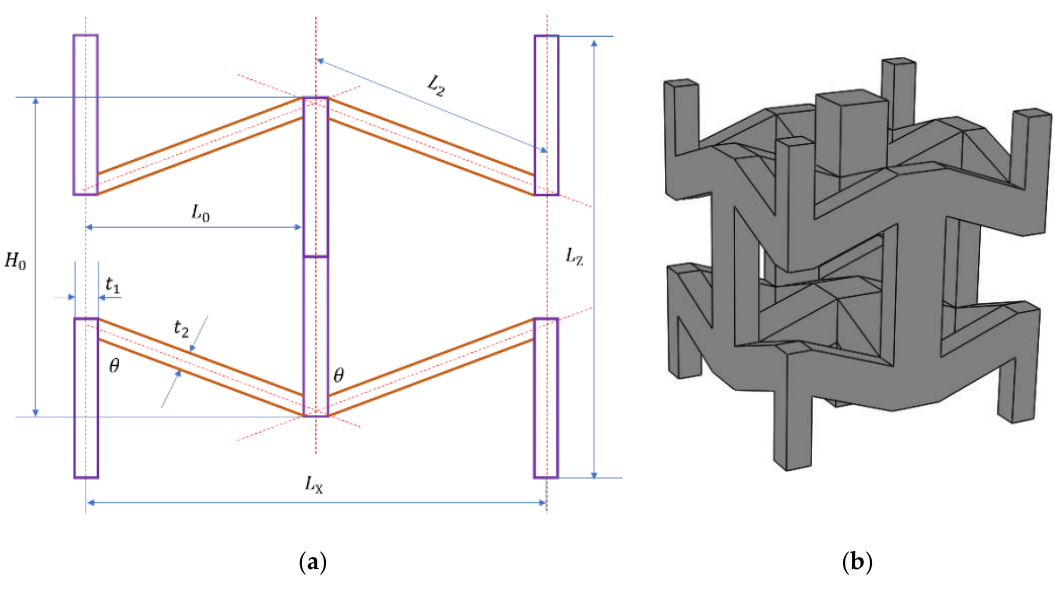
Figure 1. ( a ) Geometric parameters of unit cell [21]; ( b ) 3D unit cell [22].